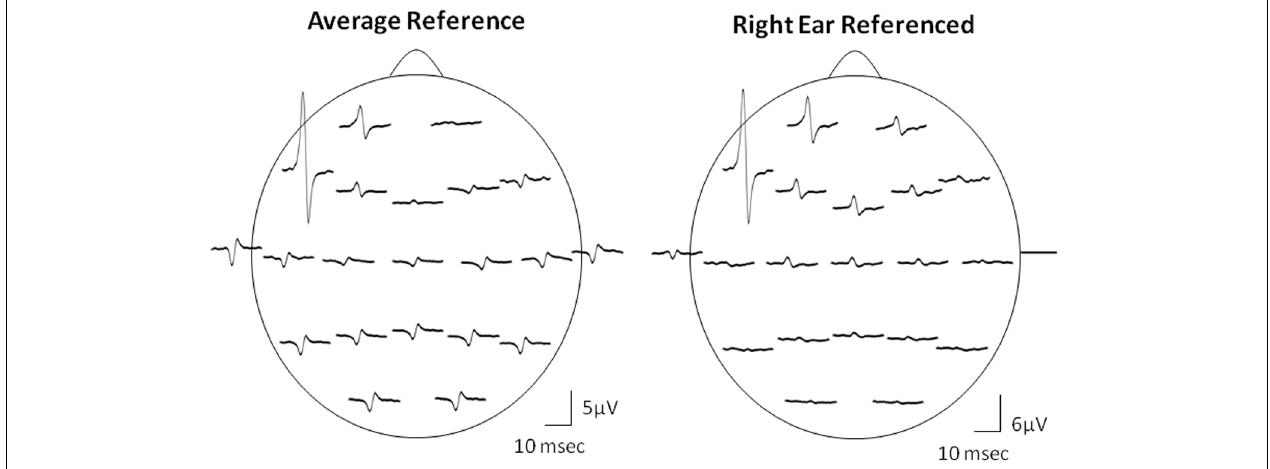
FIGURE 7 | Effect of referencing. Comparison of AR and RE montages for the topography of Macro-EMEG representations from one SMU. Amplitude and polarity of potentials differ between the two references. The RE reference emphasized the anterior temporalis location more than the AR in